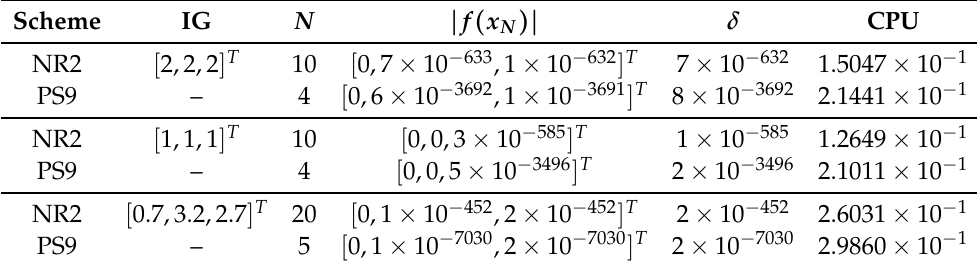
Table 11. Numerical results for problem 6 with different initial